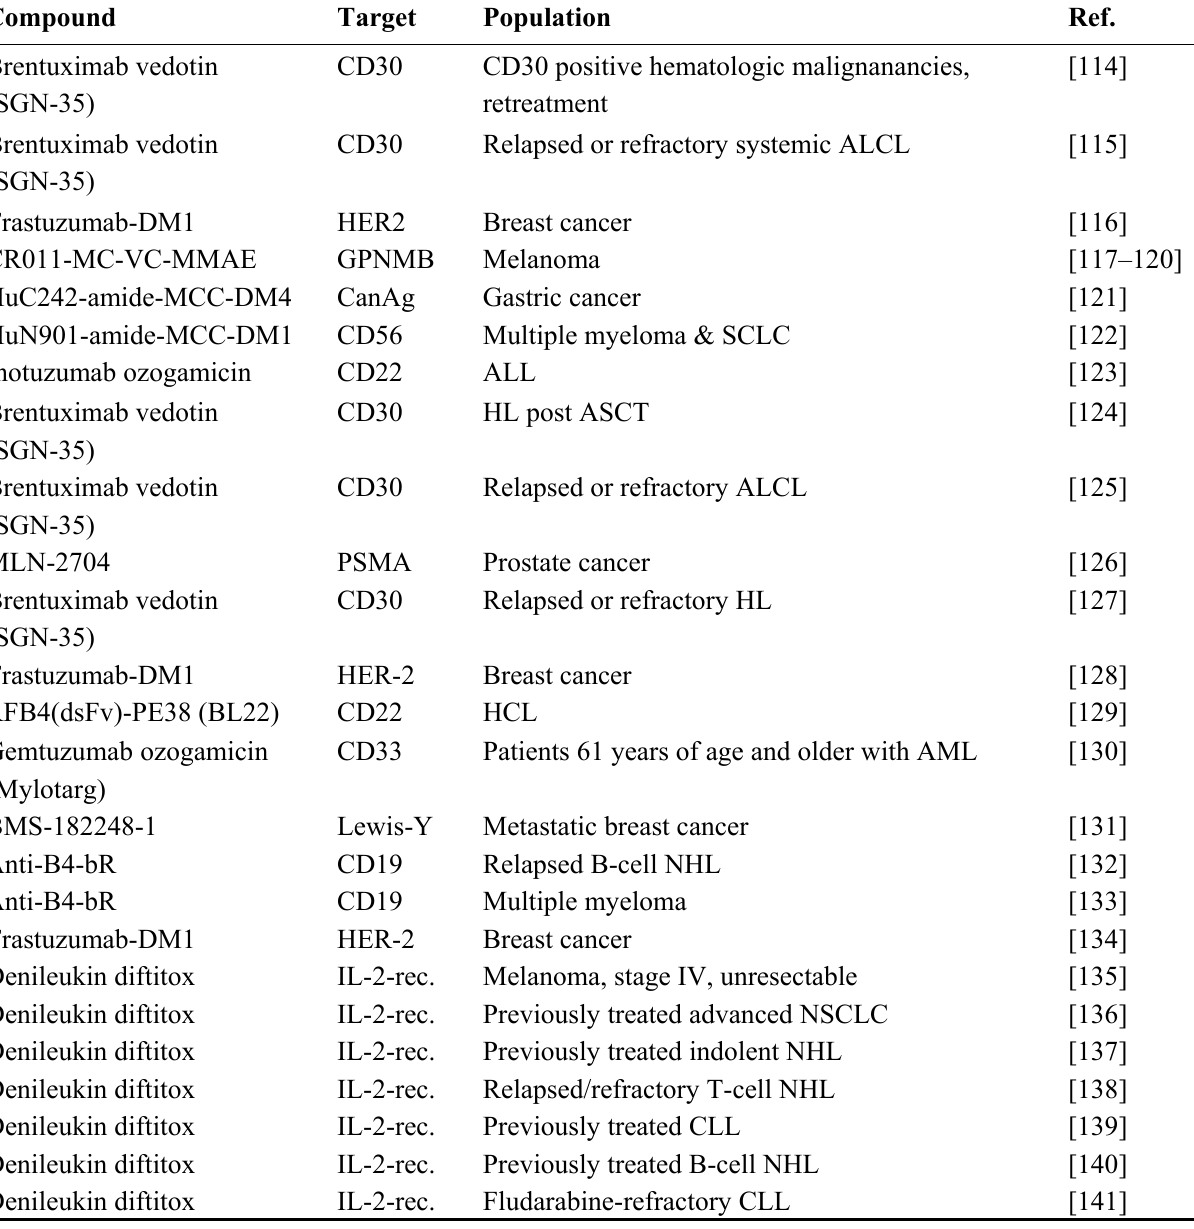
Table 2. Conjugated substances in phase II trials with their antigen and